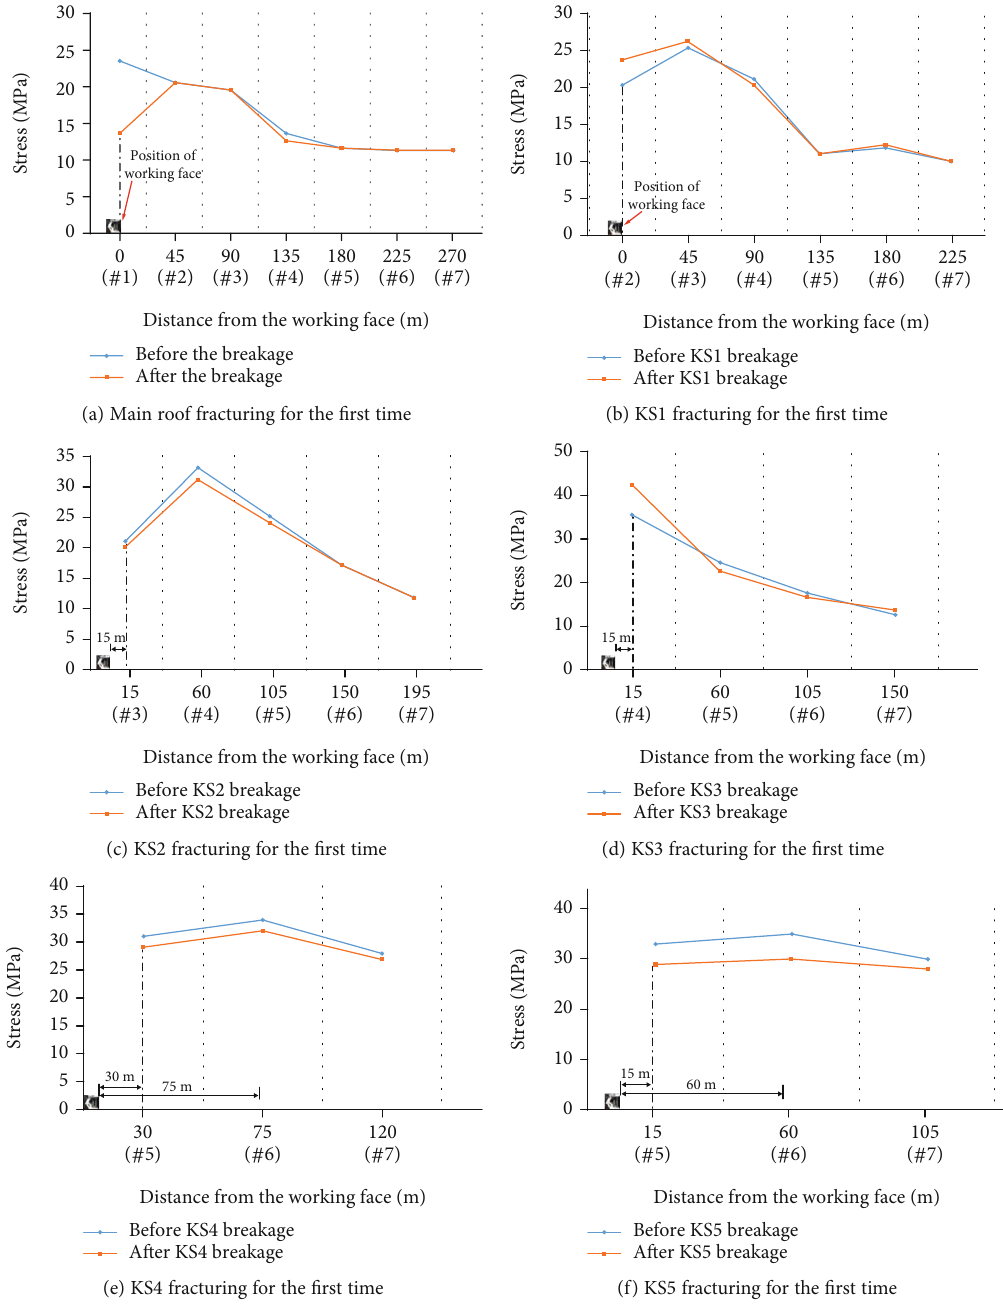
Figure 4: Stress distribution during the overburden